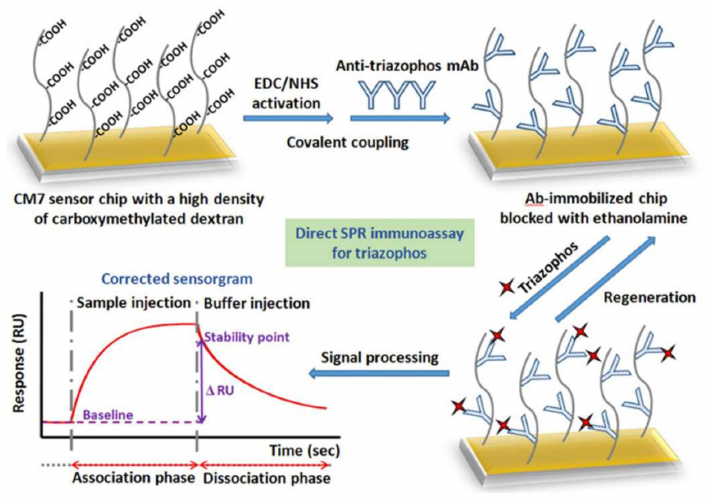
Figure 3. Preparation of Ab-immobilized sensor chip for direct detection of triazophos with real-SPR (reprinted with permission from